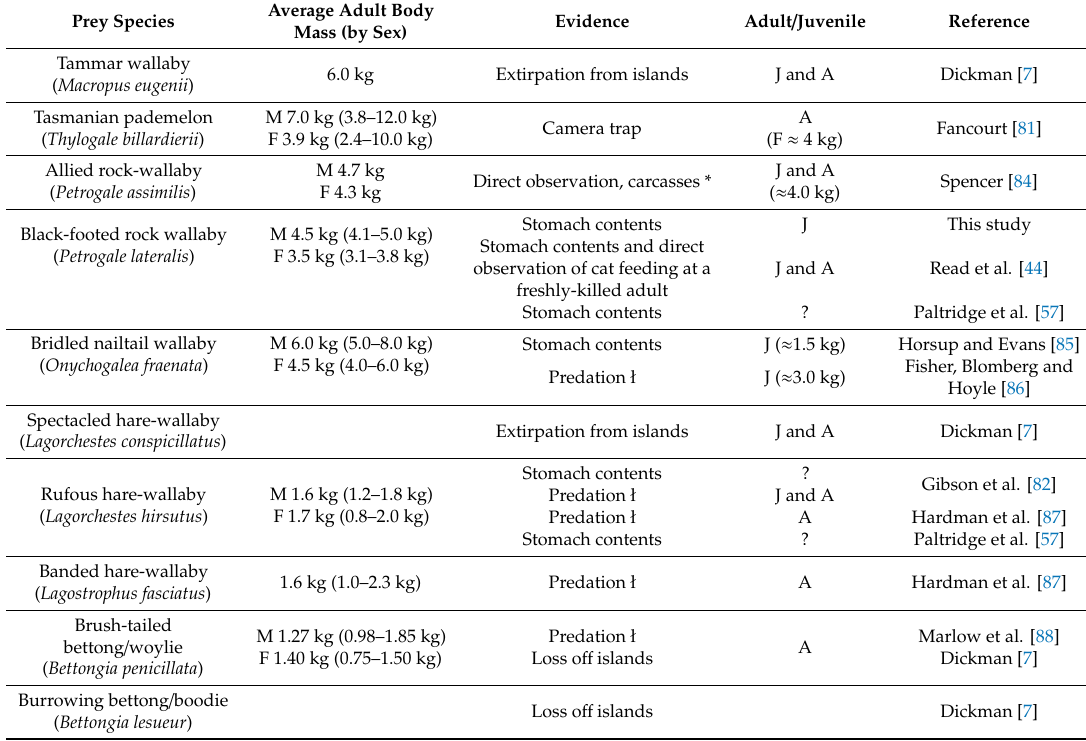
Table 5. Evidence of feral cats ( Felis catus ) killing medium-sized Australian mammals (1 kg or larger); all these species are of conservation significance. For reference, the body mass of cats in our studies averaged 3.08 ± 1.24 kg, n = 568. Unless given by specific publications (e.g., Page et al. [83]), body mass measures of prey species are from Van Dyck and Strahan